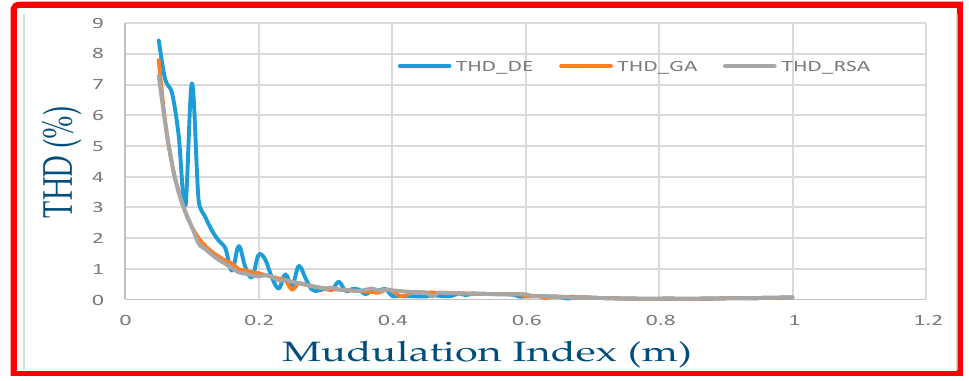
Figure 14. Different modulation index (m) variations of THD using RSA, DE, and GA for the nine − level inverter.